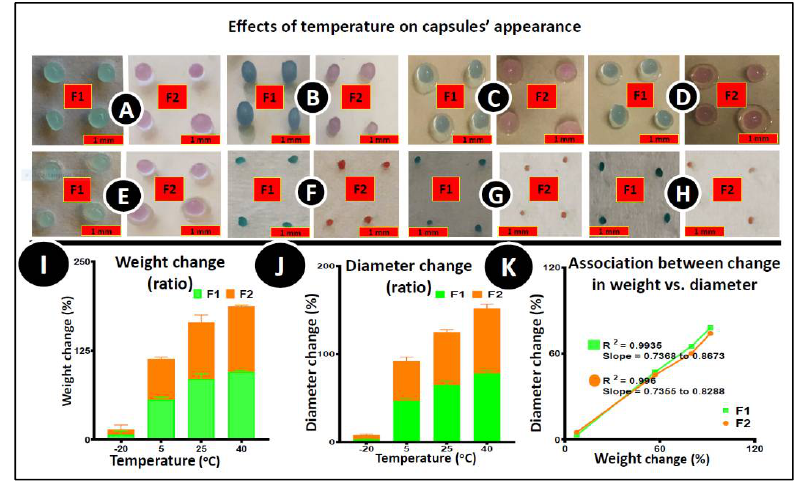
Figure 4. Effect of temperature on the microcapsules’ appearance. Pictures were taken before ( A – D ) and after the accelerated stability testing ( E – H ); ( I ) % change in weight, ( J ) % change in diameter and ( K ) correlation between % changes in diameter and % change in weight. N = 3, mean ±